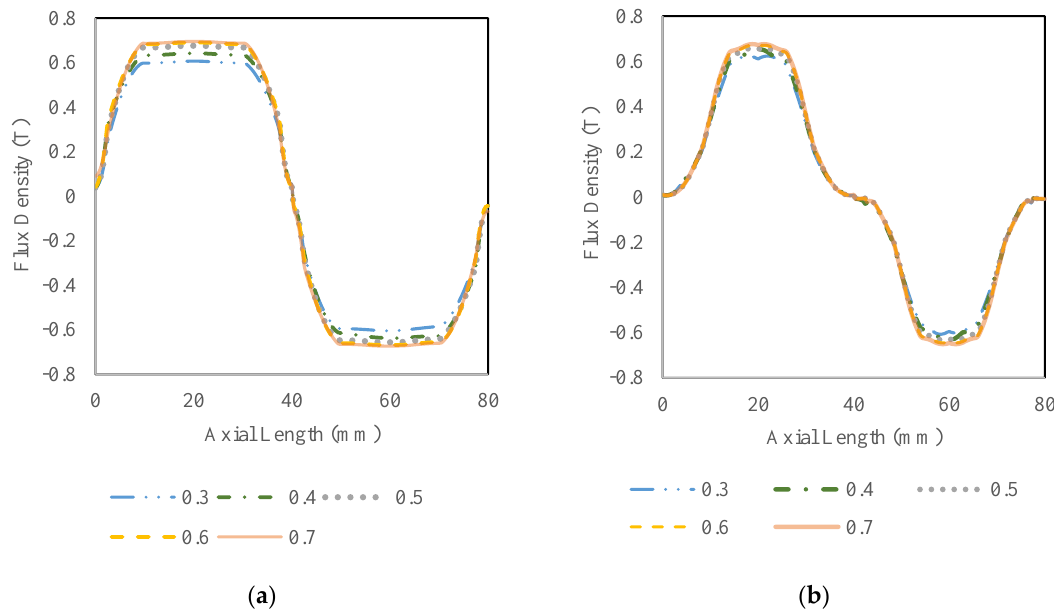
Figure 14. Influences of Split Ratio, R m /R e on Airgap Flux Density of ( a ) TPMLM-NS; ( b ) TPMLM-S.